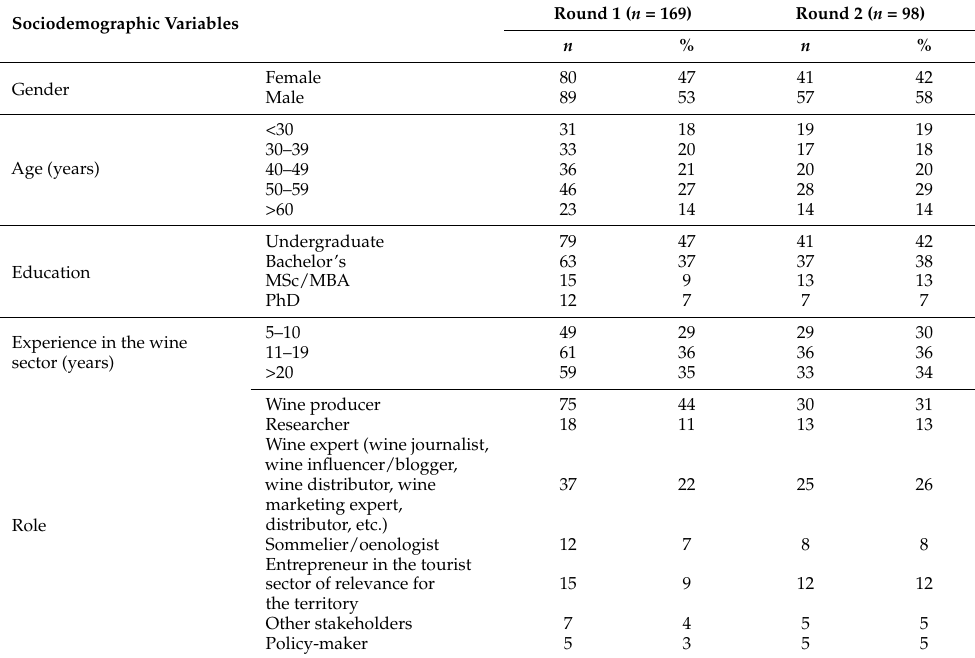
Table 2. Socio-demographic summary of respondents’